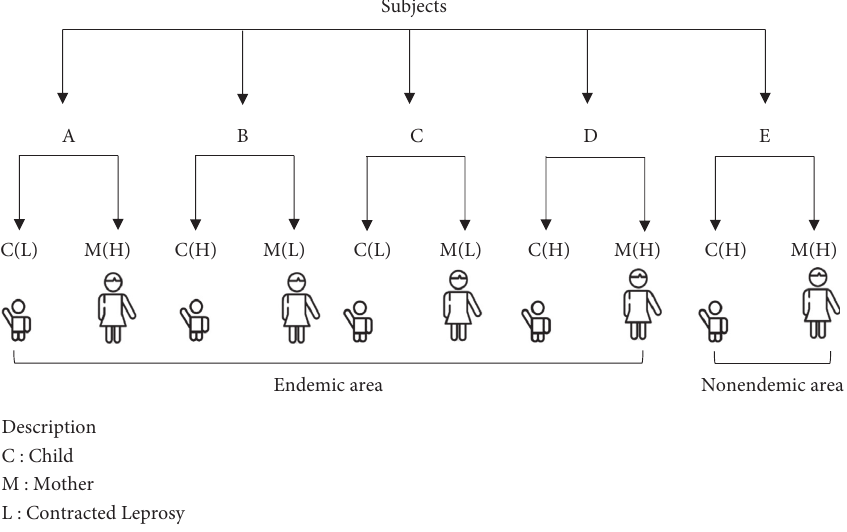
Figure 1: The schematic of subject